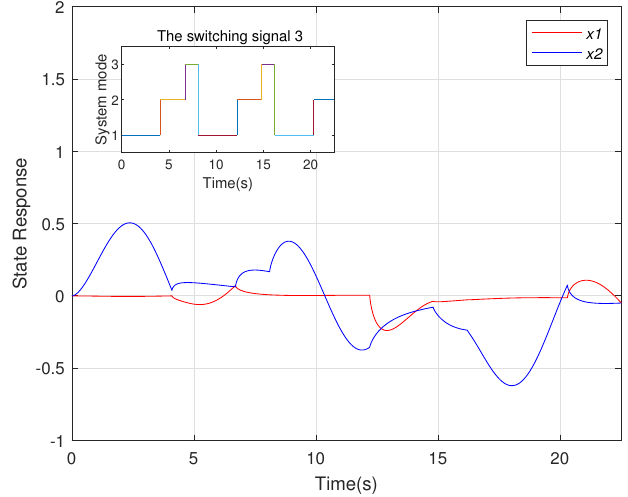
Figure 3. The state response of the system under the signal 3.